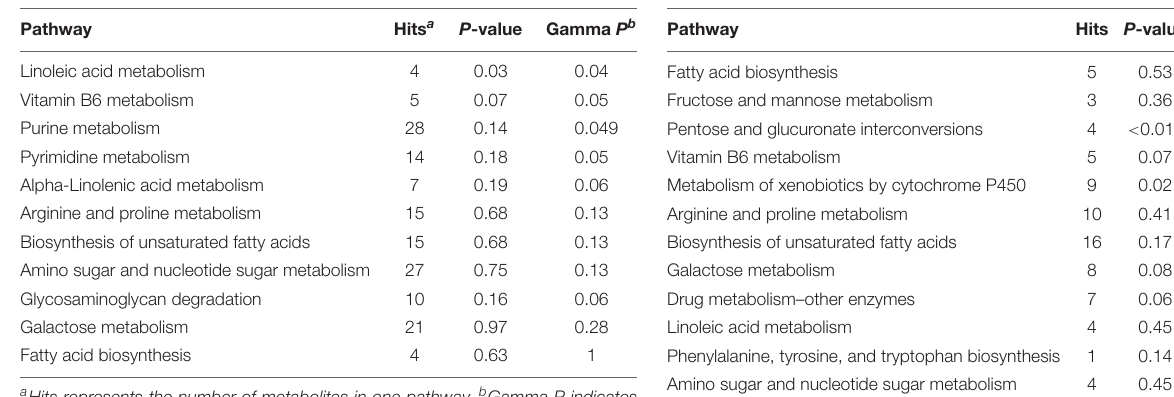
TABLE 3 | Analysis of enriched metabolic pathways in buffalo and cow milk for positive ion mode.